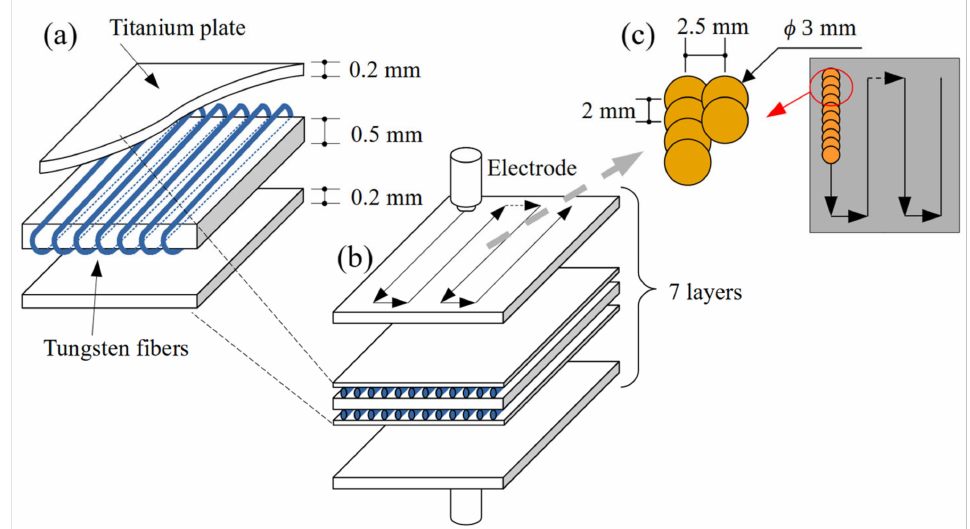
Figure 1. Schematic diagram of ( a ) 0.5 mm thick titanium plate with tungsten fibers wound at regular intervals and sandwiched between other 0.2 mm thick titanium plates; ( b ) seven layers of these materials prepared in ( a ) are stacked up and spot-welded; ( c ) the overlapping condition of the welded part in the continuous spot-welding method, and the welding path on the surface of W/Ti composite.